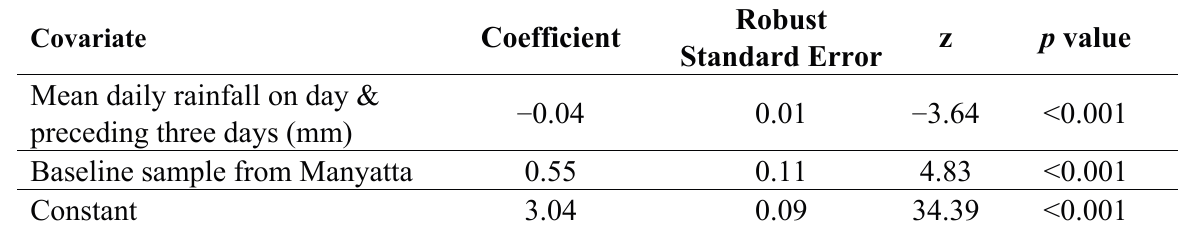
Table 4. Interval regression results, showing risk factors for thermotolerant coliform contamination of hand-dug wells at baseline (2002–2004) and in 2014 (n = 253, Wald chi squared =